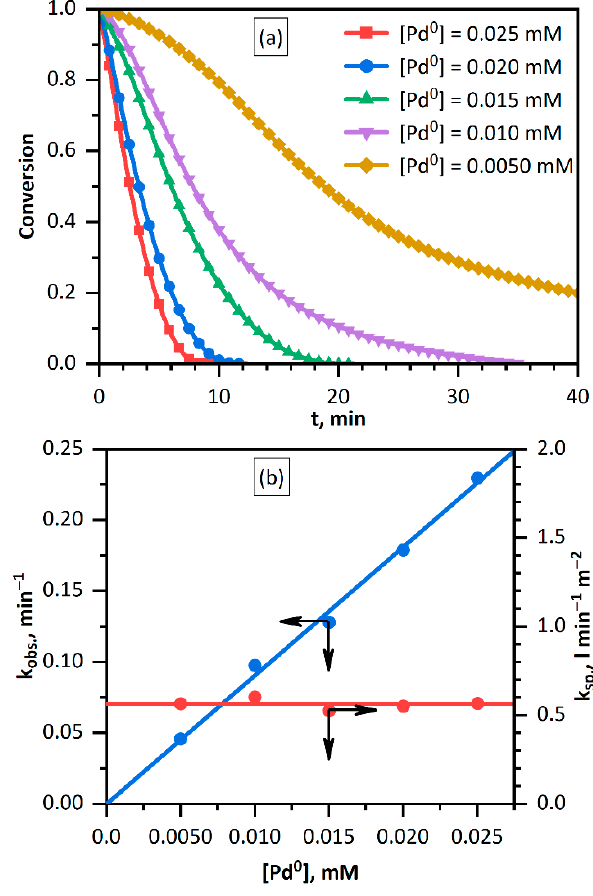
Figure 2. ( a ) Kinetic curves for the reduction of Fe(CN) 63 – ions with hydrogen in the presence of various amounts of palladium. ( b ) Observed and specific rate constants of the reduction of Fe(CN) 63 – ions with hydrogen vs. palladium concentration. Solution: [ Fe(CN) 63 – ] = 1.00 mM, [H 2 ] = 0.80 mM (p(H 2 ) = 1.025 atm).